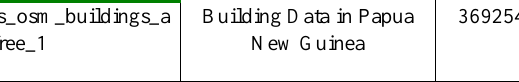
Table 6 . Experimental dataset